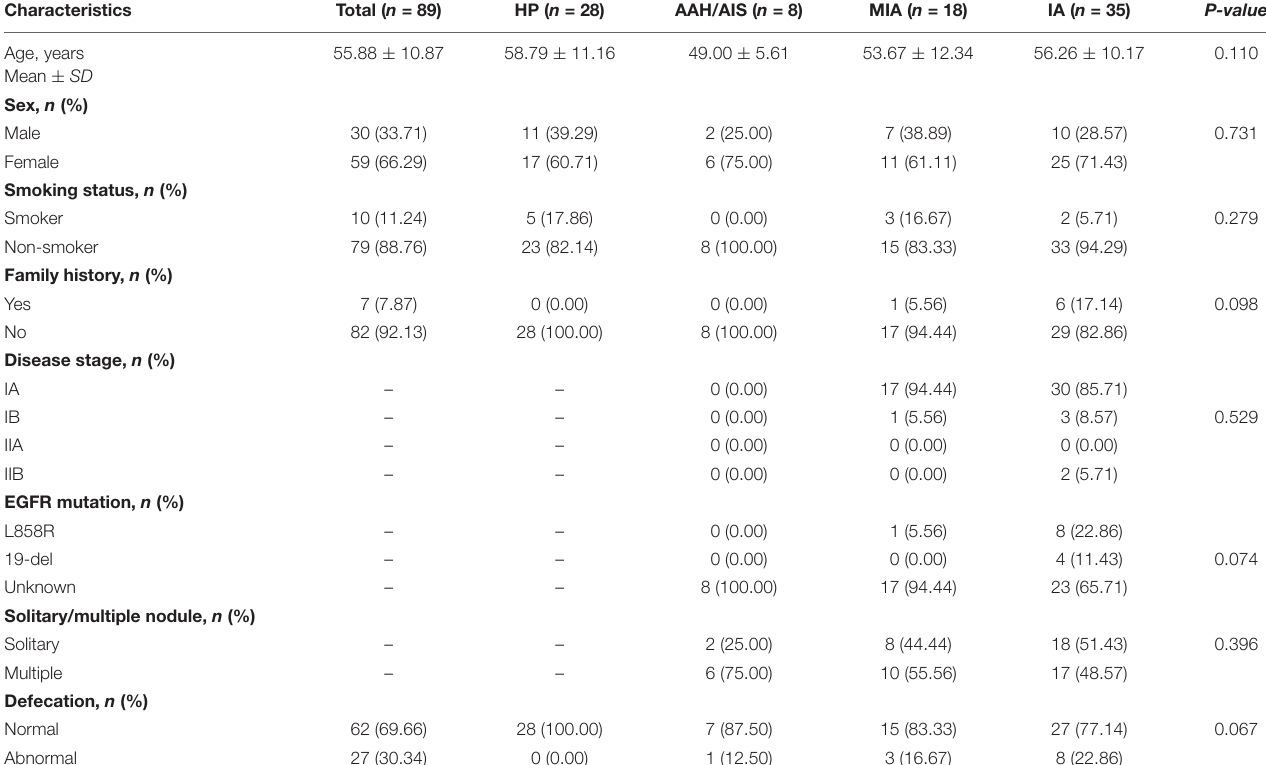
TABLE 1 | Baseline characteristics of health people and non-small cell lung cancer (NSCLC) patients.